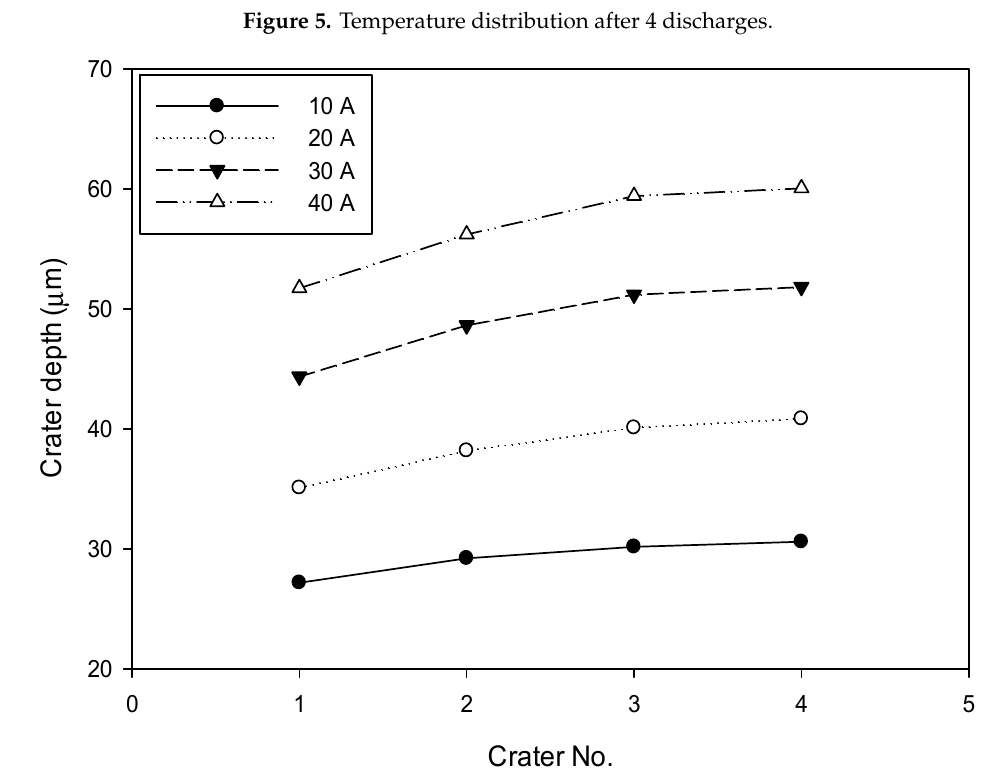
Figure 5. Temperature distribution after 4 discharges.